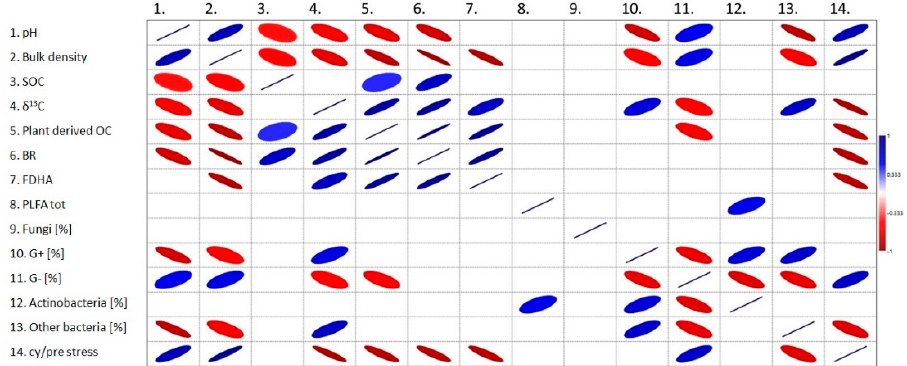
Figure 8. Spearman correlation matrix between studied soil parameters ( ρ : − 1 strong negative, ρ : +1 strong positive). SOC: Soil organic carbon; δ 13 C: Ratio of carbon isotopes; OC: Organic carbon; BR: Basal respiration; FDHA: Fluorescein diacetate hydrolytic activity; PLFA tot: total PLFA (living microbial biomass); G + : Ratio of Gram-positive bacteria; G − : Ratio of Gram-negative bacteria; cy/pre stress: Indicator of cyclopropylated fatty acids to their precursors, indicator of transition of bacteria to stationary growth phase .